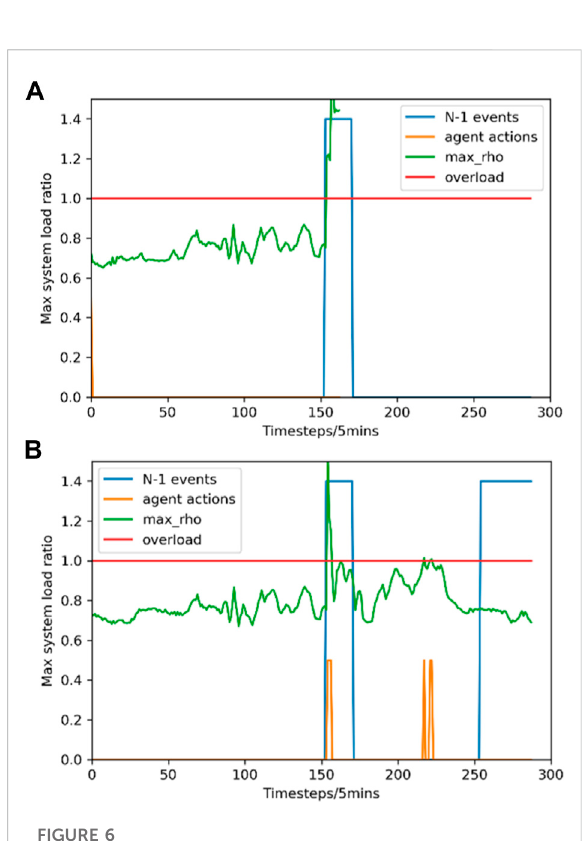
FIGURE 6 System operation status comparison between two methods in Scenario II. (A) Expert policy; (B) PKE-RL